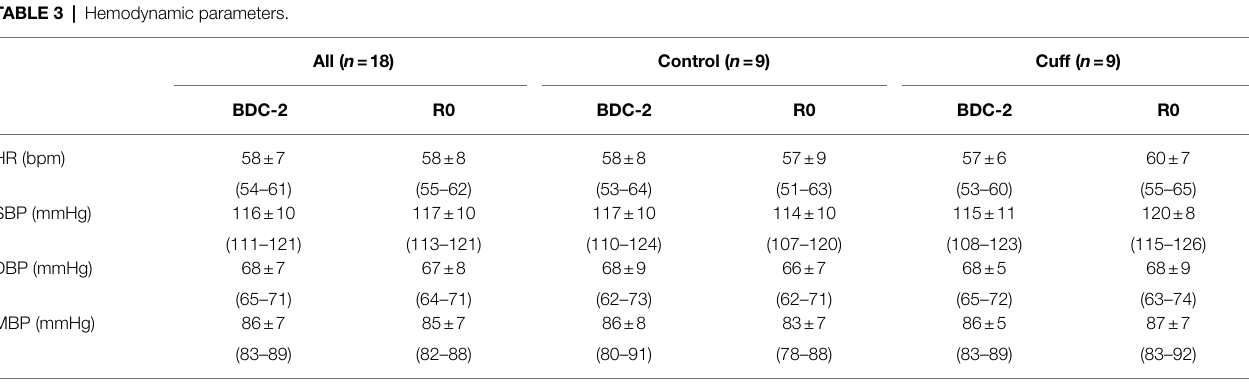
TABLE 3 | Hemodynamic